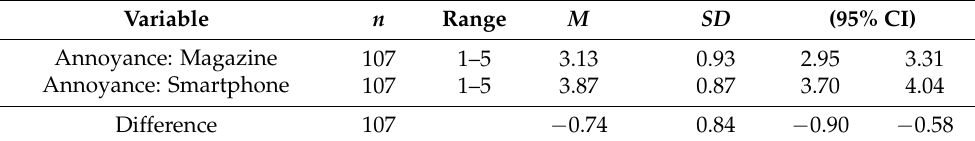
Table 1. Paired sample t -test in sample 1.